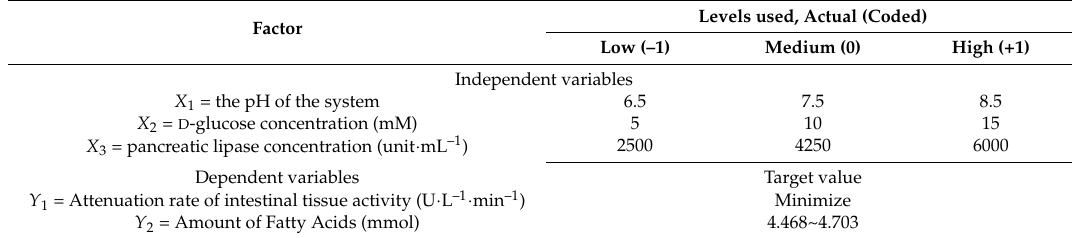
Table 1. Variables and their levels in the Box-Behnken